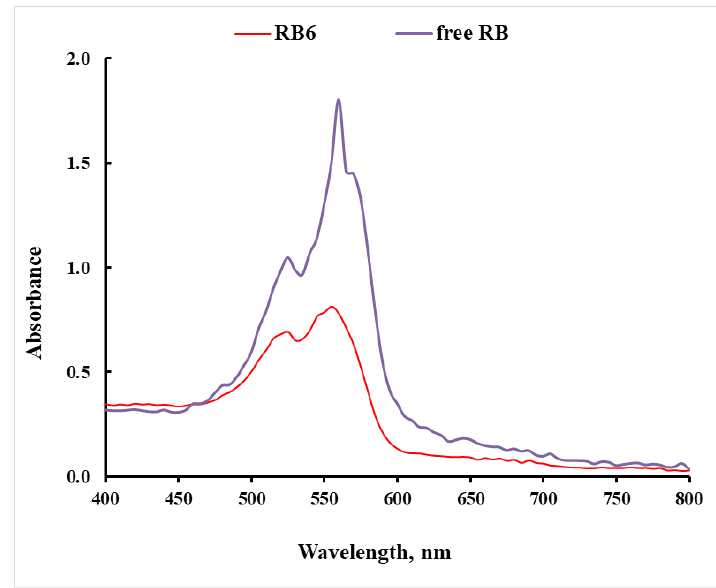
Figure 4. Visible spectra of free RB and RB6